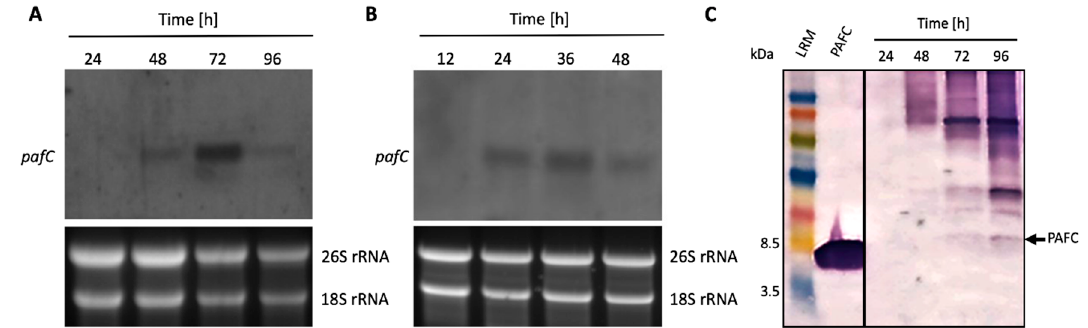
Figure 2. Expression of the PAFC encoding gene and protein. Total RNA was extracted from ( A ) mycelium grown in submersed and ( B ) synchronized surface cultures up to 96 h. Ten µ g of total RNA was loaded per lane on a 1.2% denaturing agarose gel, blotted onto a nylon membrane and hybridized with a pafC specific digoxigenin-labelled PCR probe (upper panels). Ethidium bromide-stained 26S and 18S rRNA provide loading controls (lower panels). ( C ) For Western blot analysis, 20 µ L of the cell free supernatant from submersed cultures was loaded per lane, size fractionated on an 18% ( w / v ) SDS-polyacrylamide gel and transferred onto a nitrocellulose membrane. A polyclonal antibody generated against PeAfpC was used to probe for PAFC. Recombinant PAFC (0.5 µ g) was used as a control for antibody binding. The black arrow indicates PAFC (6.6 kDa). LRM, low range rainbow marker (GE Healthcare Life Sciences, Little Chalfont, UK). The molecular weight marker bands of 3.5 kDa and 8.5 kDa are indicated.